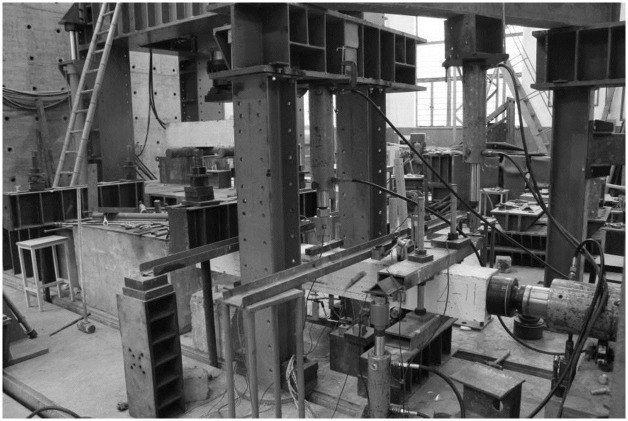
Experimental device.